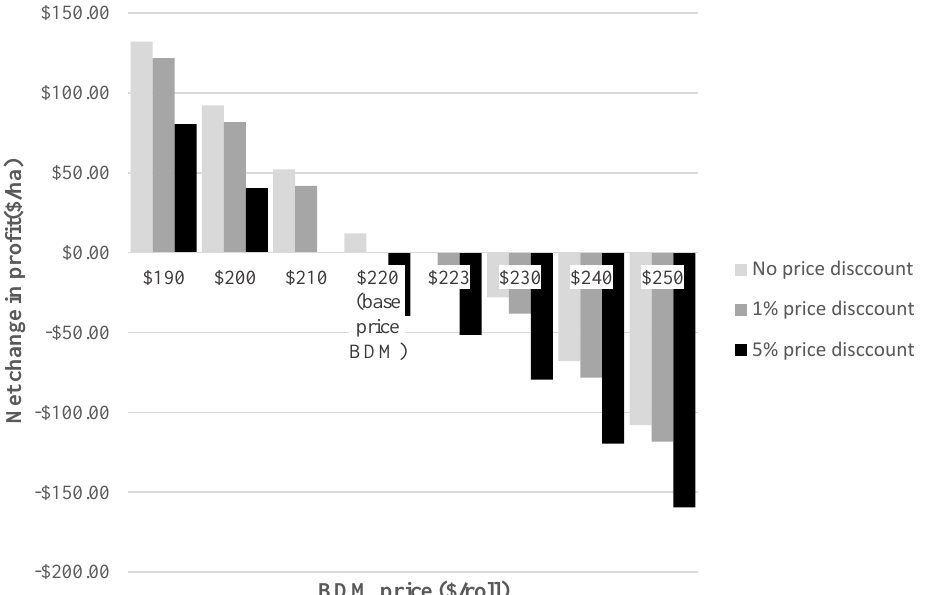
Figure 1. Net changes in profit associated with the adoption of BDM given different BDM prices and pumpkin price discounts (no pumpkin price discount; 1% and 5% pumpkin price discount).